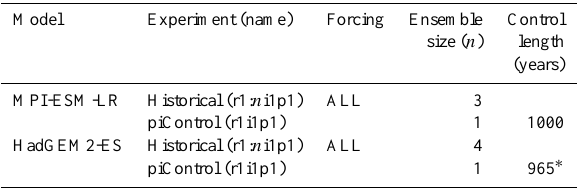
Table 1. Summary of CMIP5 model output used in the optimal detection, comprising MPI-ESM-LR and HadGEM2-ES historical and piControl integrations. ALL = natural + anthropogenic external forcing. * control length after drift